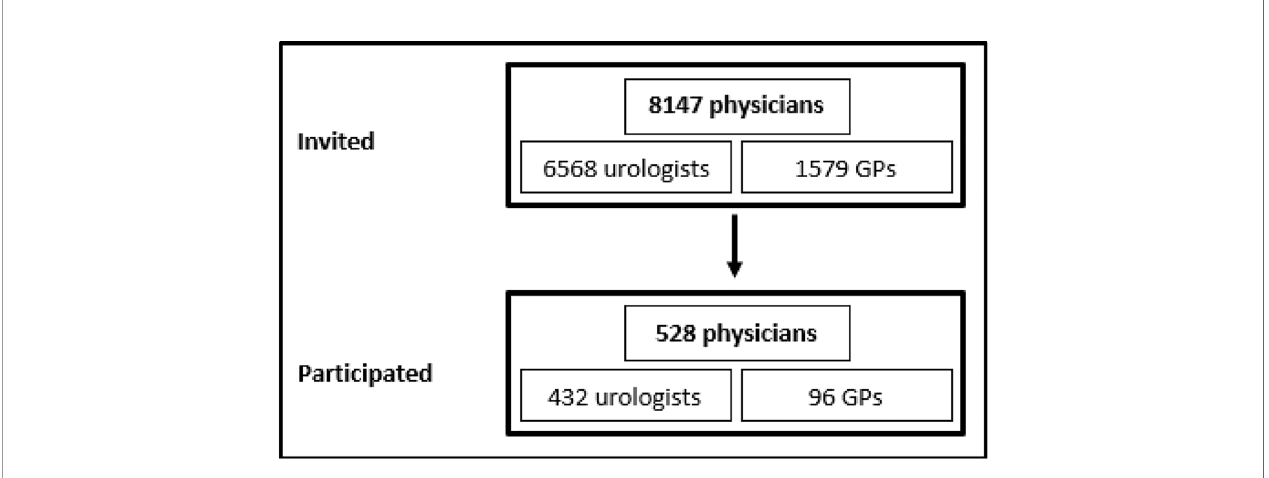
FIGURE 1 | Flowchart of survey participants. GPs, general practitioners.